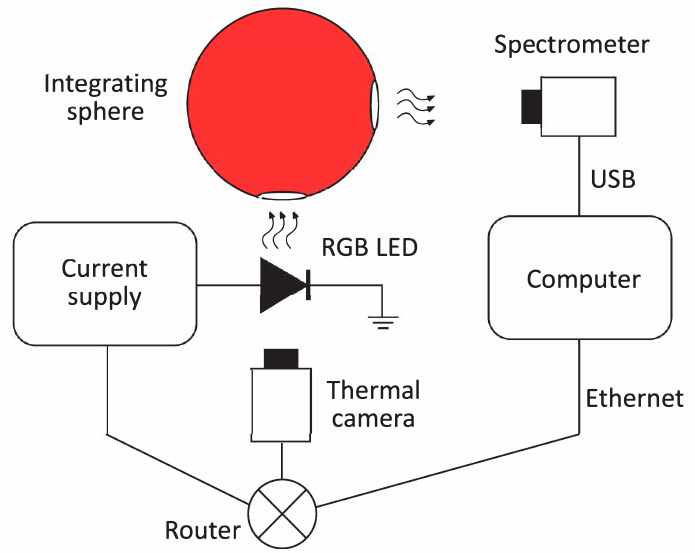
Figure 3. Diagram of the experimental setup.